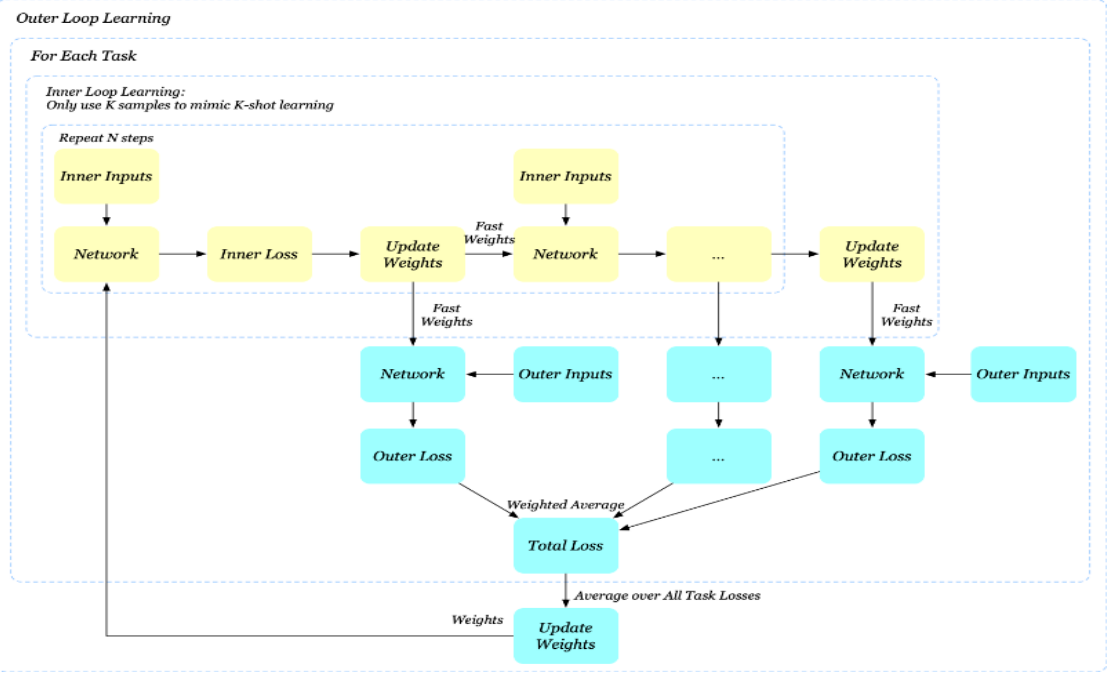
Figure 4. MAML++ visualization. Figure 4. MAML ++